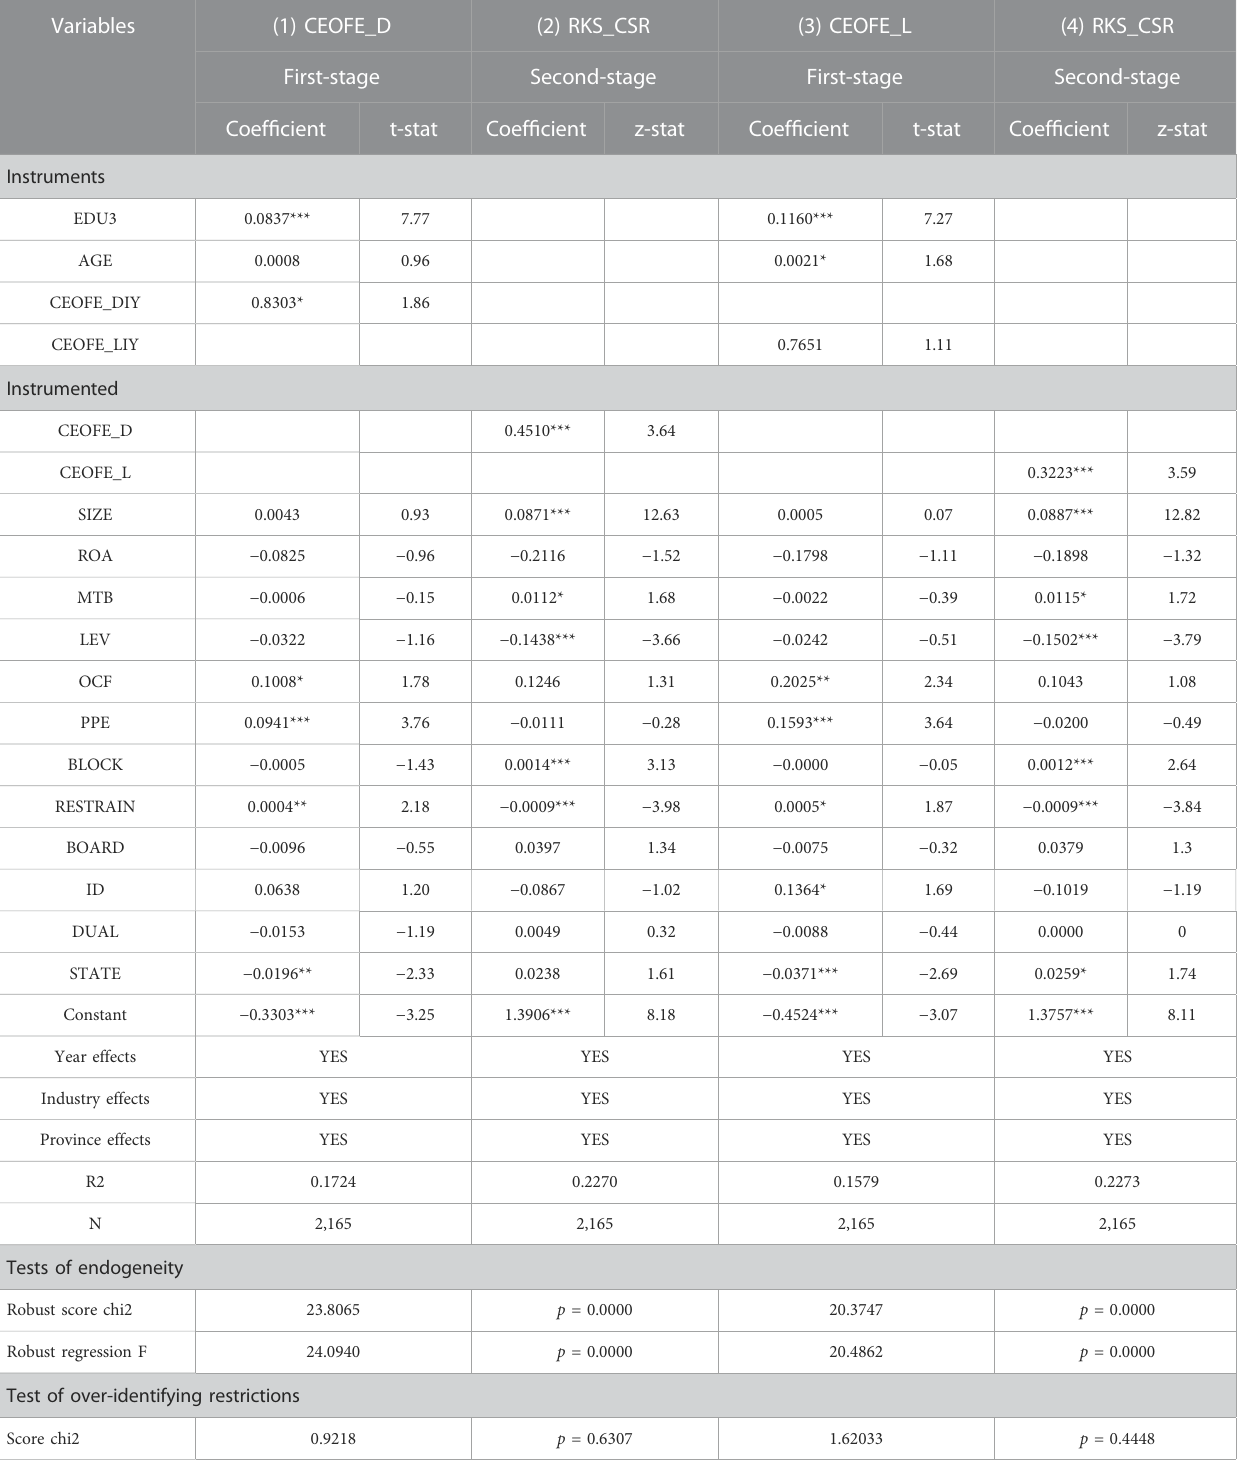
TABLE 6 CEO ’ s foreign experience and CSR (Instrumental variables).